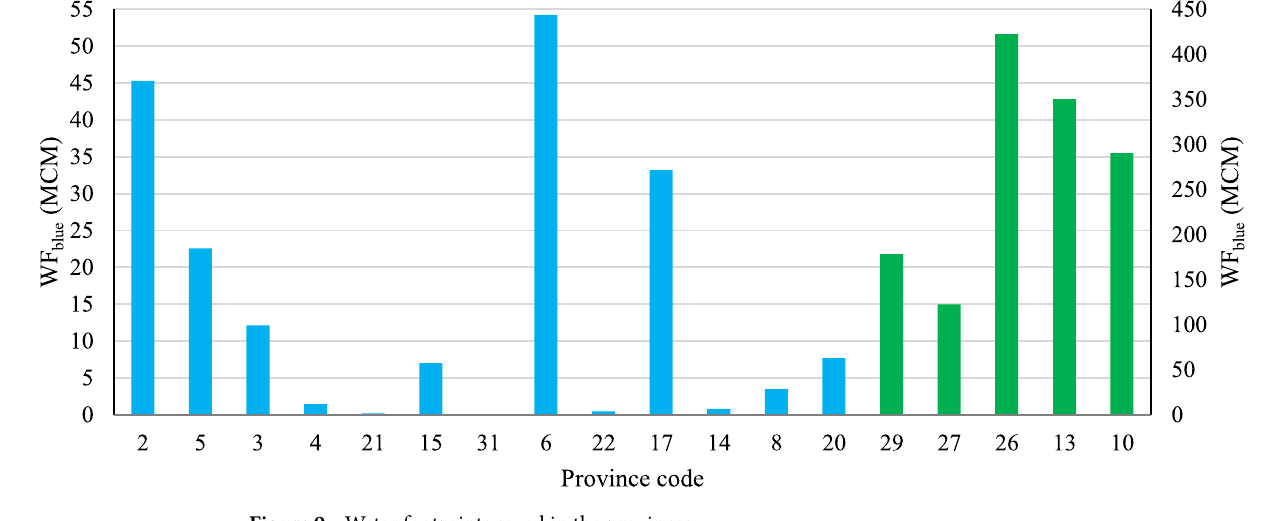
Figure 9. Water footprints saved in the provinces.